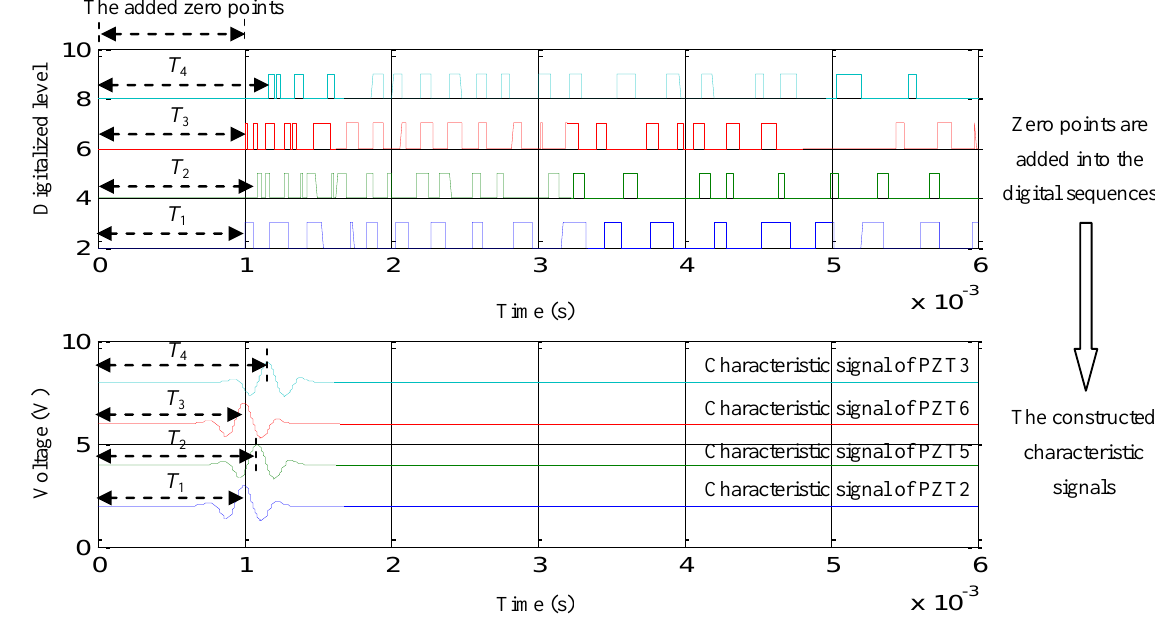
Figure 9. The demonstration of the characteristic signals